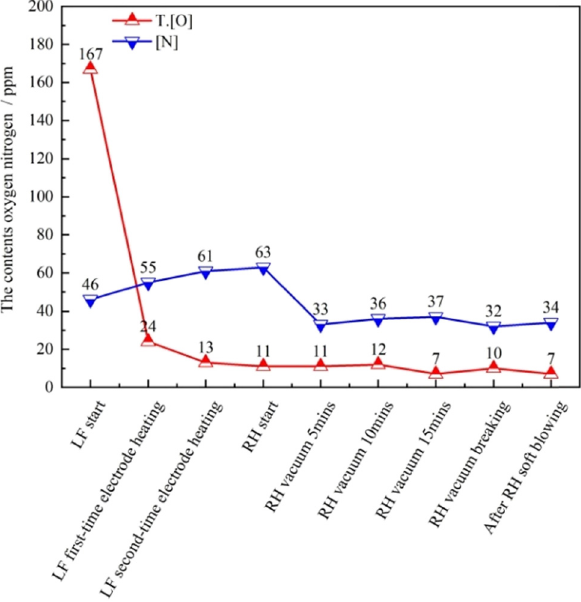
Figure 1: Evolution of contents of TO and TN during LF – RH re fi ning process in heavy rail steel.